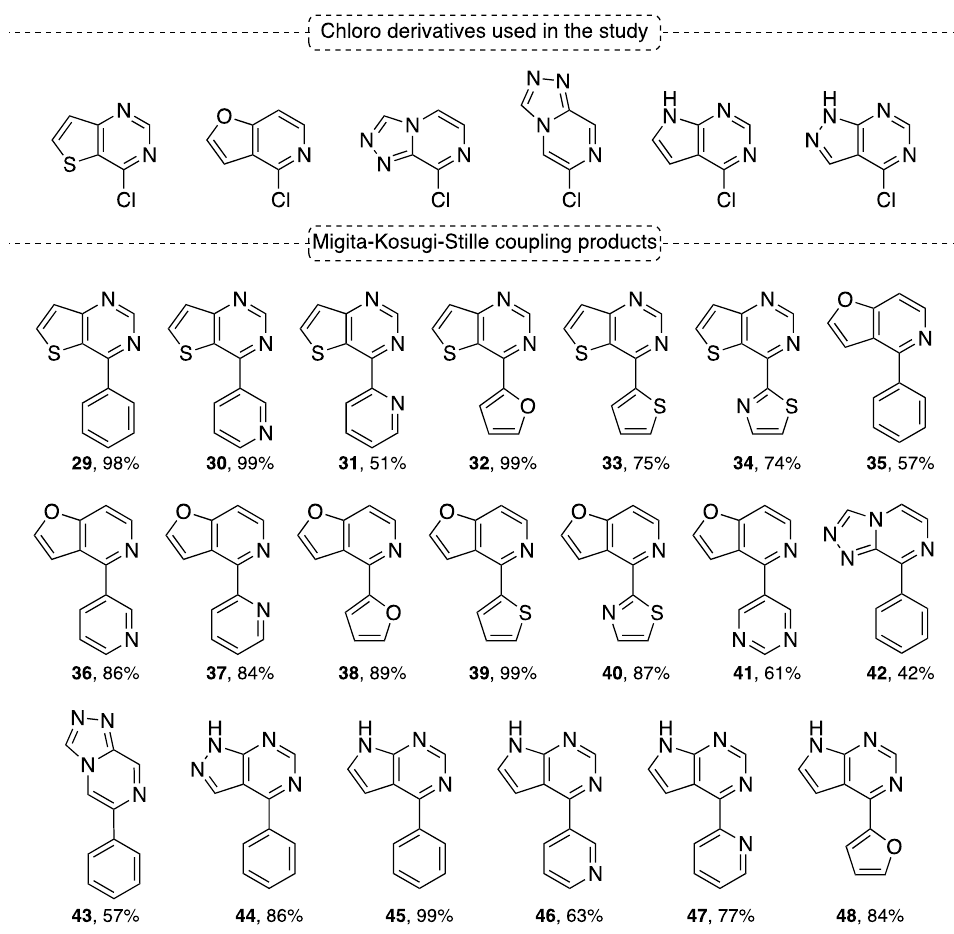
Figure 6. Migita – Kosugi – Stille coupling products in eucalyptol [128]. Figure 6. Migita–Kosugi–Stille coupling products in eucalyptol